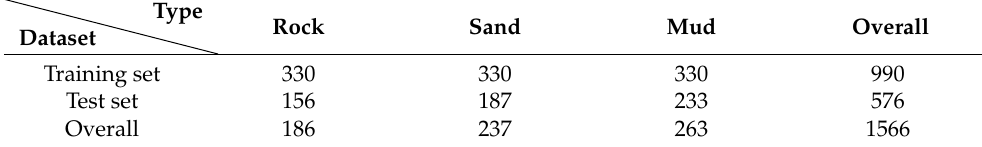
Table 5. The augmented dataset was also divided into a training set and a test set. The generated sediment images are assigned to the augmented training set, and the test set is the same as the original test set.